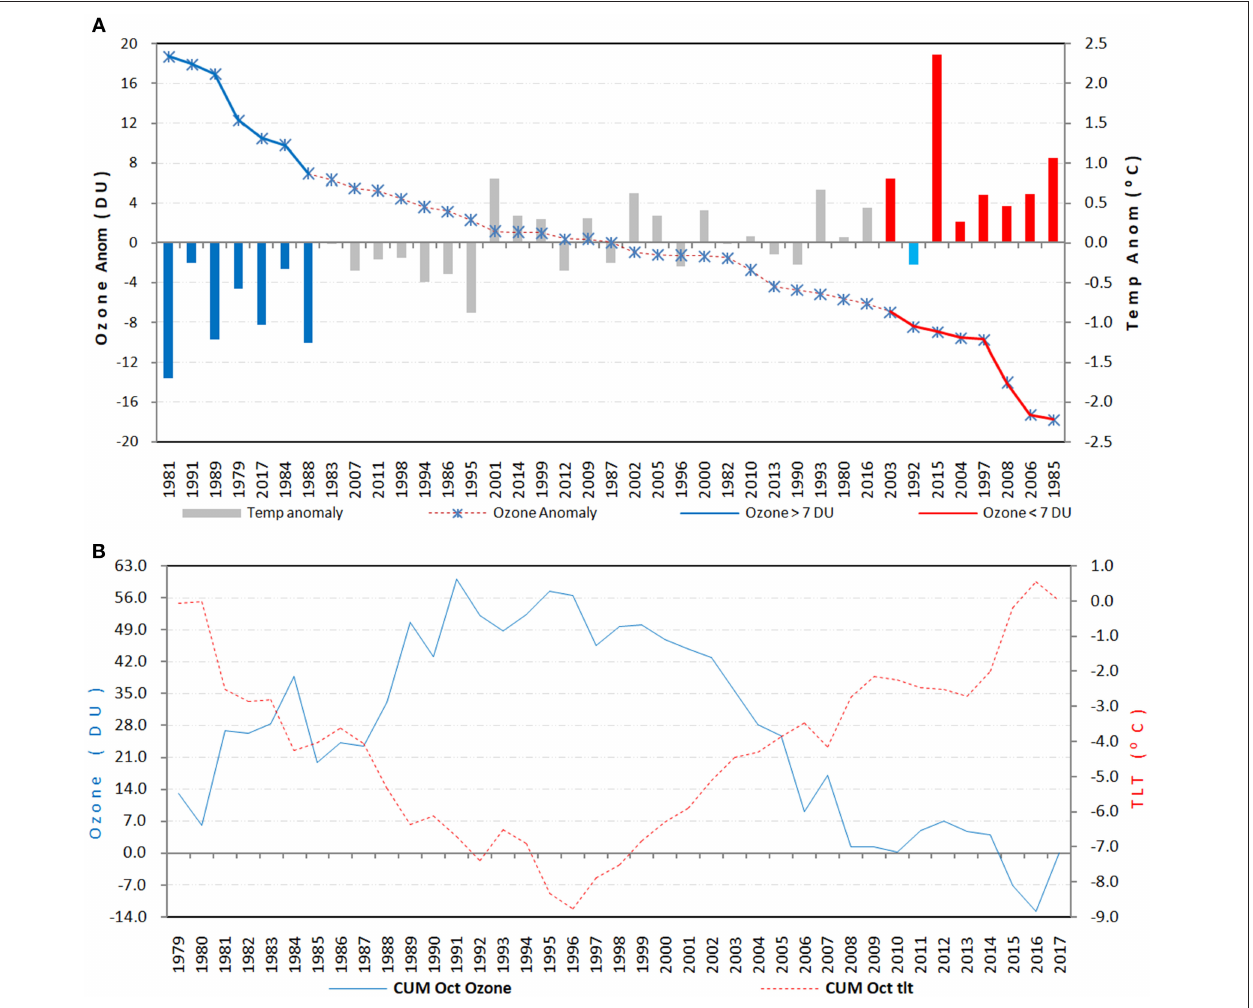
FIGURE 1 | (A) Temporal manifestation for the SA-ozone anomaly (DU) that is arranged in descending order (broken line with asterisks) with the corresponding SA_SATmax anomalies ( ◦ C). Blue (red) bars represent SA_SATmax anomalies matching the extreme ozone anomalies that are greater (less) than 7 DU while gray bars stand for those with smaller magnitudes. The light blue bar amongst the red bars is the year 1992 which we considered an outlier. (B) The CUSUM time series for October ozone (broken red line) alongside that of October TLT (solid blue line). The data are for October from 1979 to